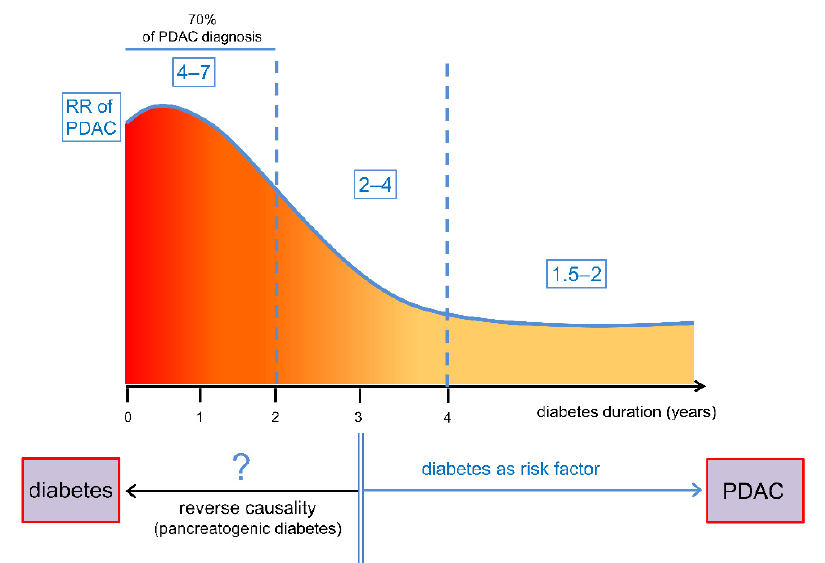
Figure 1. Relationship between diabetes and pancreatic cancer. The epidemiological association between diabetes and pancreatic ductal adenocarcinoma (PDAC) is complex, leading to divergent and even opposing views on the nature of the relationship. Please refer to the main text for details and references. RR = relative risk.